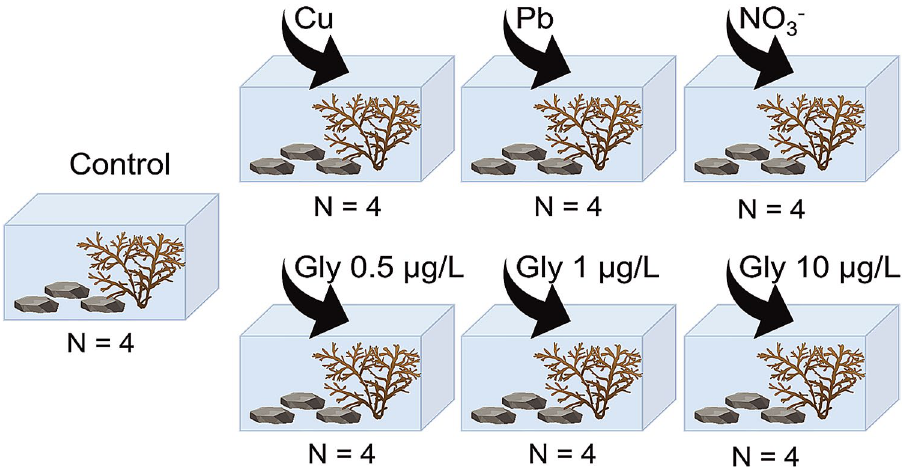
Figure 1. Experimental setup. Four replicate tanks (20 L) were used for each treatment (control without pollutant, 4 µM nitrate, 30 µg/L copper, 10 µg/L lead, and glyphosate at 0.5 µg/L, 1 µg/L and 10 µg/L). In each tank, one adult individual of Carpodesmia crinita and three stones (to provide substrata for the settlement of the zygotes) were placed. All tanks were maintained at 18 °C for 6 months, continuously aerated by air pumps, with a natural light regime and with a constant flow of natural seawater in a closed